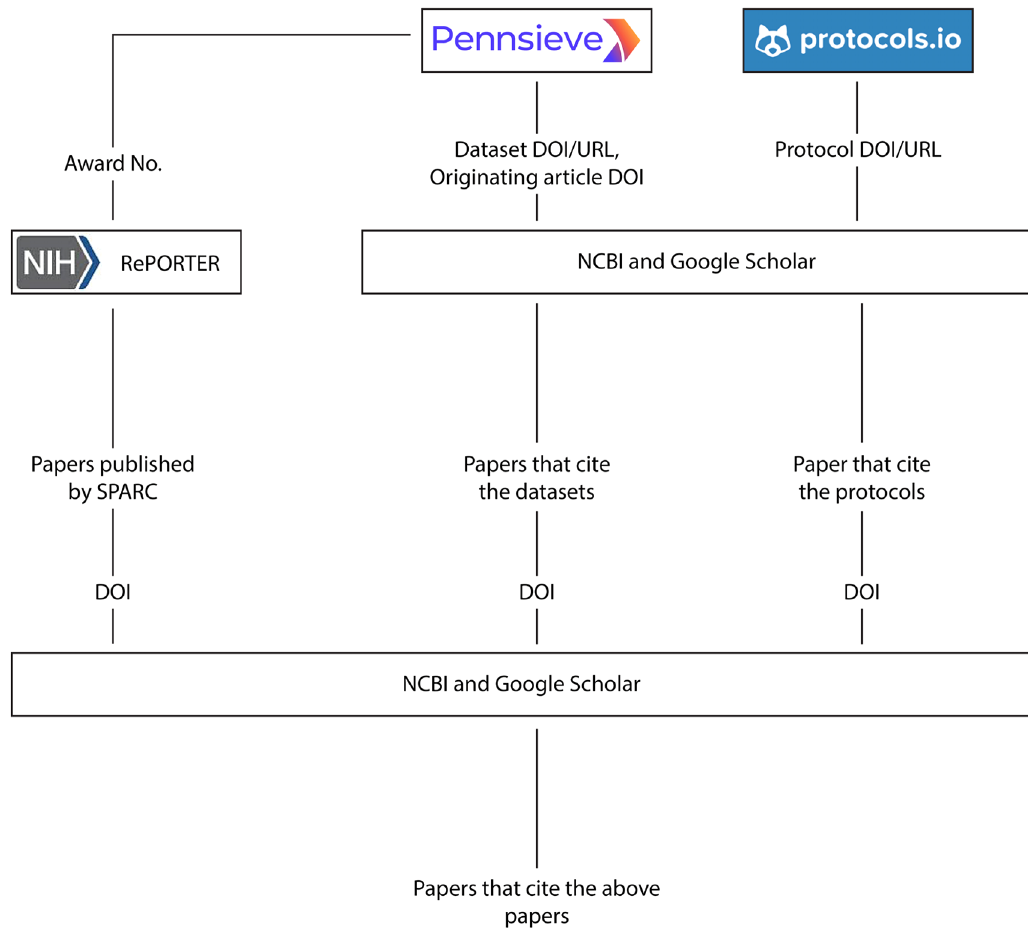
Figure 2. Methods implemented to gather citations of datasets, protocols, SPARC, and external publications.